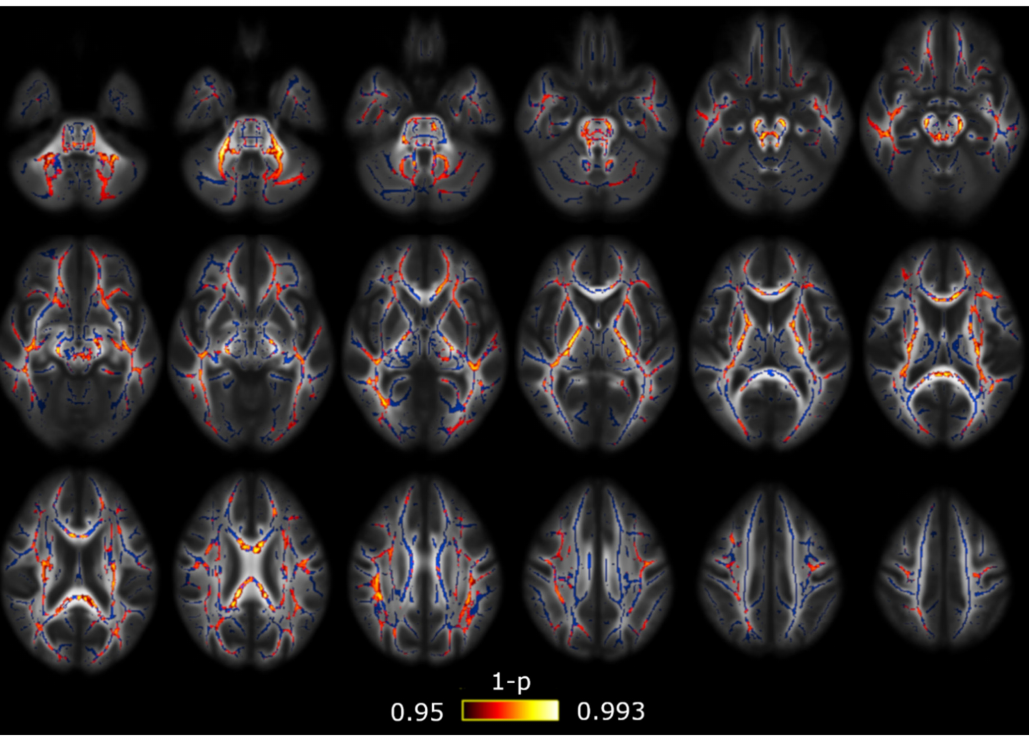
Figure 2. Axial di ff usivity (AD) alterations in patients with CM in comparison with patients with EM. Widespread significant lower AD values were found in CM. The white matter skeleton is shown in blue and voxels with significant di ff erences in red-yellow. The color bar shows the 1-p values (family-wise error corrected). Table 2. White matter regions from the ICBM-DTI-81 White Matter Atlas for which significant decreased AD values were found in CM compared to